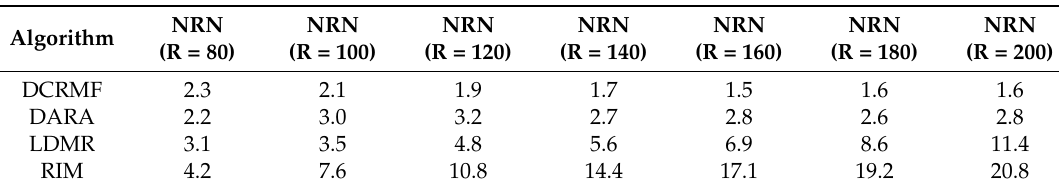
Table 7. Comparison of different methods on the change of number of relocated nodes with the communication range